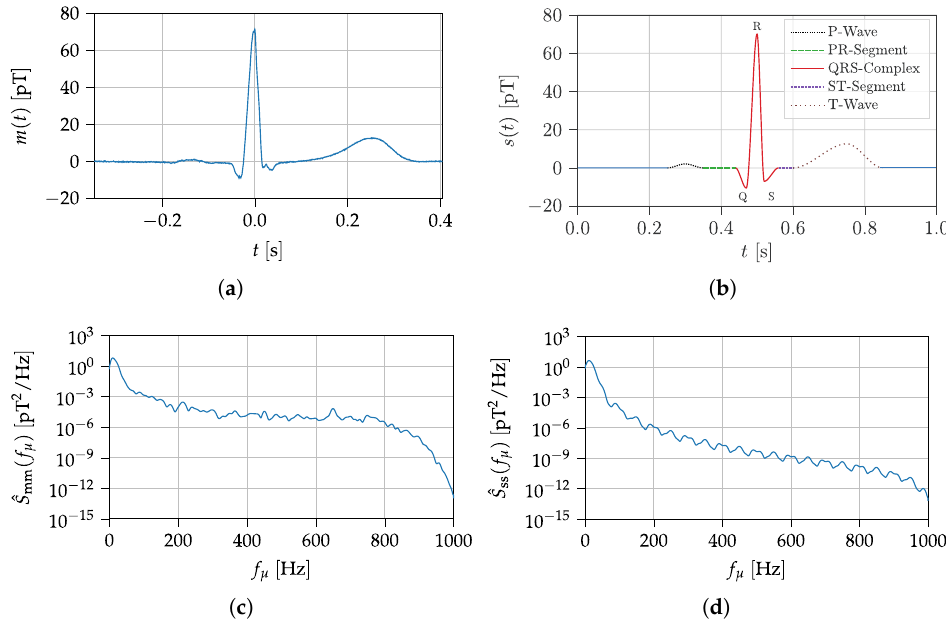
Figure 7. MCG prototype signal based on SQUID-MCG-Data. ( a ) SQUID Measurement—time domain. ( b ) Prototype MCG—time domain. ( c ) SQUID Measurement—power spectral density. ( d ) Prototype MCG—power spectral